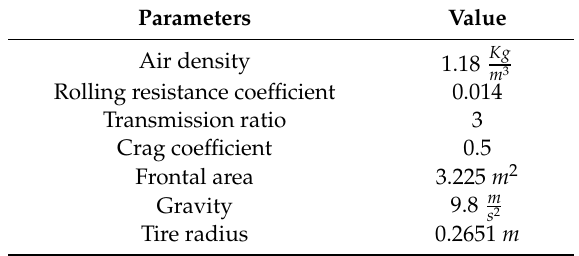
Table 1. Vehicle parameters.